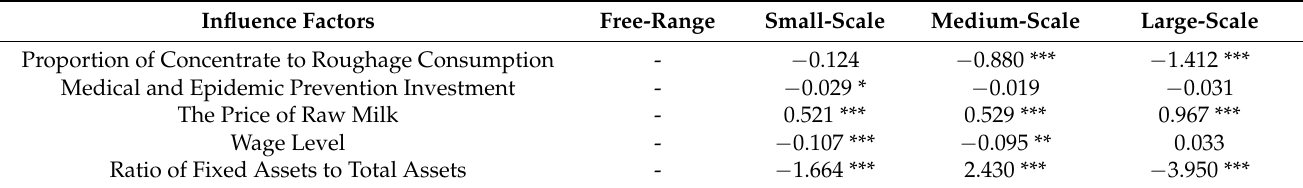
Table 11. Parameter estimation of technical inefficiency equation considering fixed